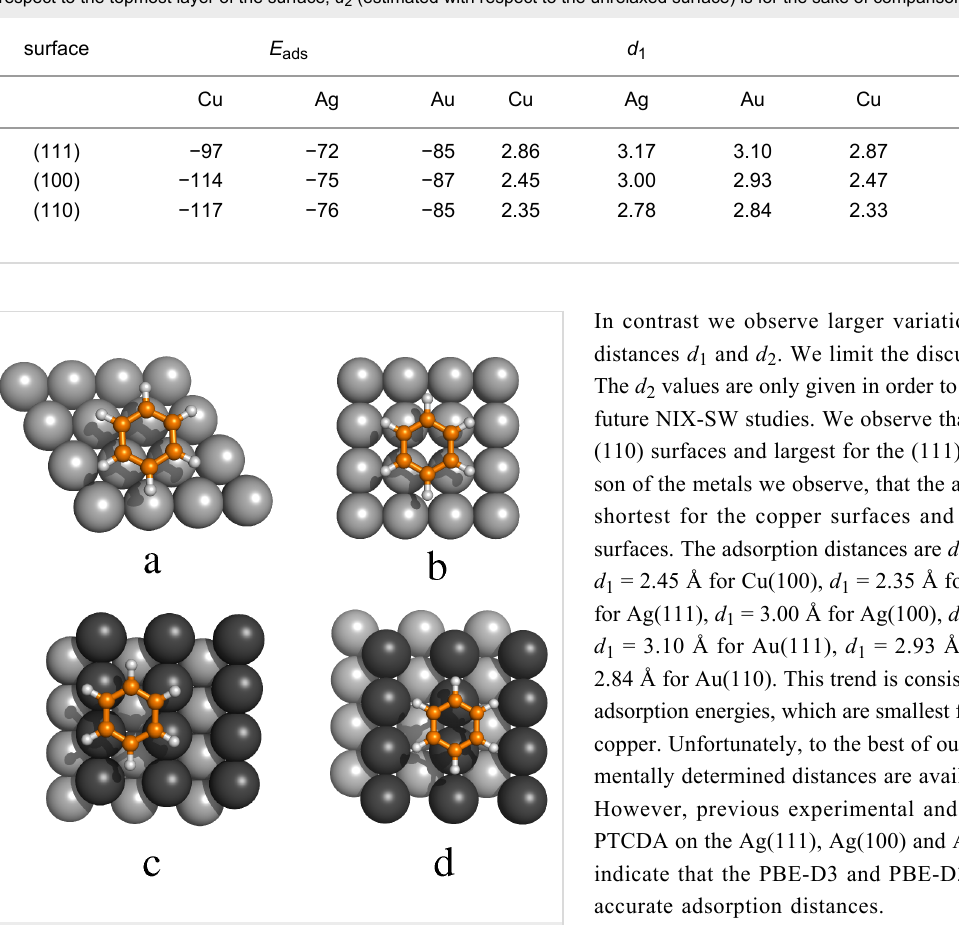
Table 1: Adsorption energies E ads in kJ/mol and adsorption distances d 1 and d 2 in Å obtained with the PBE-D3 functional. d 1 is calculated with respect to the topmost layer of the surface, d 2 (estimated with respect to the unrelaxed surface) is for the sake of comparison to NIX-SW experiments.